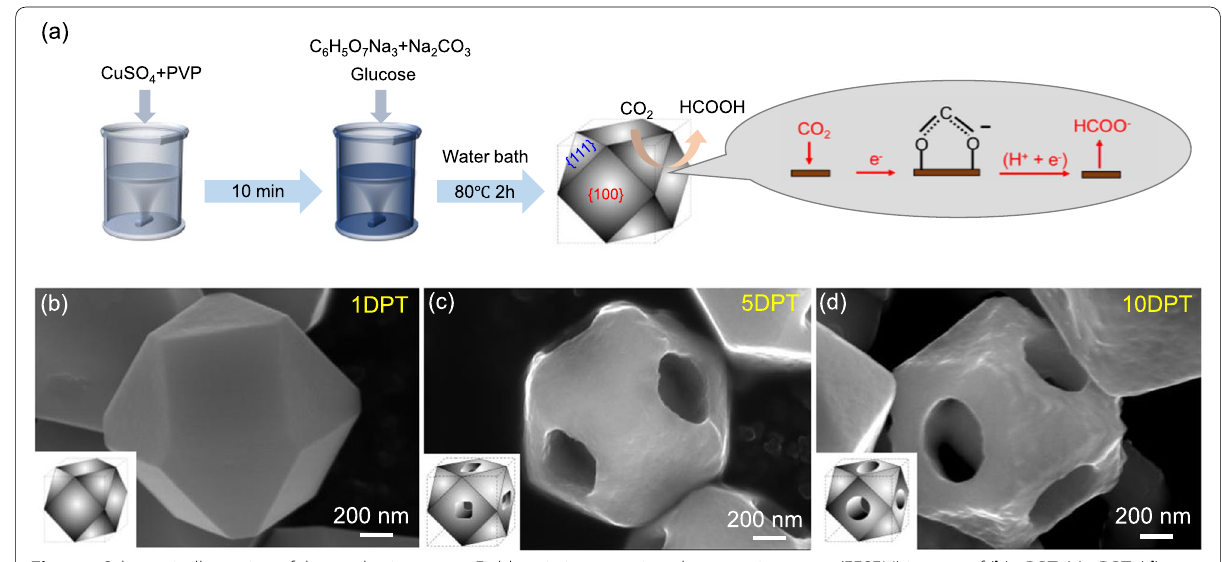
Fig. 1 a Schematic illustration of the synthesis process. Field-emission scanning electron microscopy (FESEM) images of ( b ) 1DPT; ( c ) 5DPT; ( d ) 10DPT NCs. Inset shows the corresponding crystal